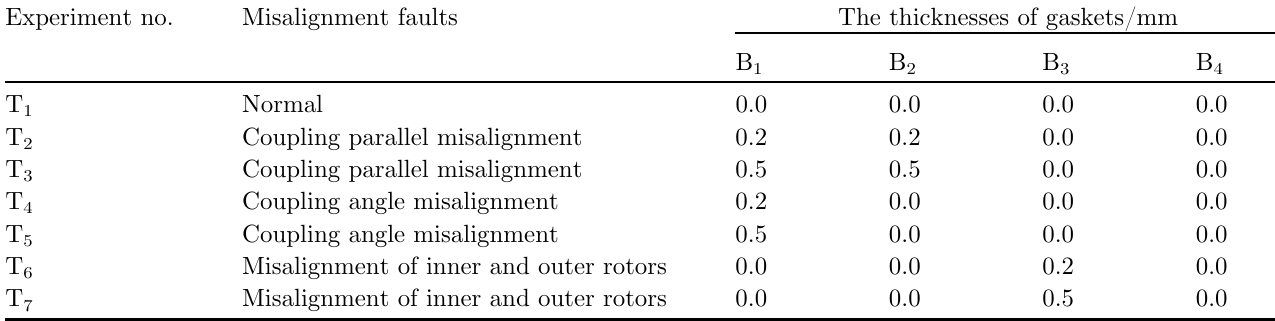
Table 1. Description of experimental conditions. Experiment